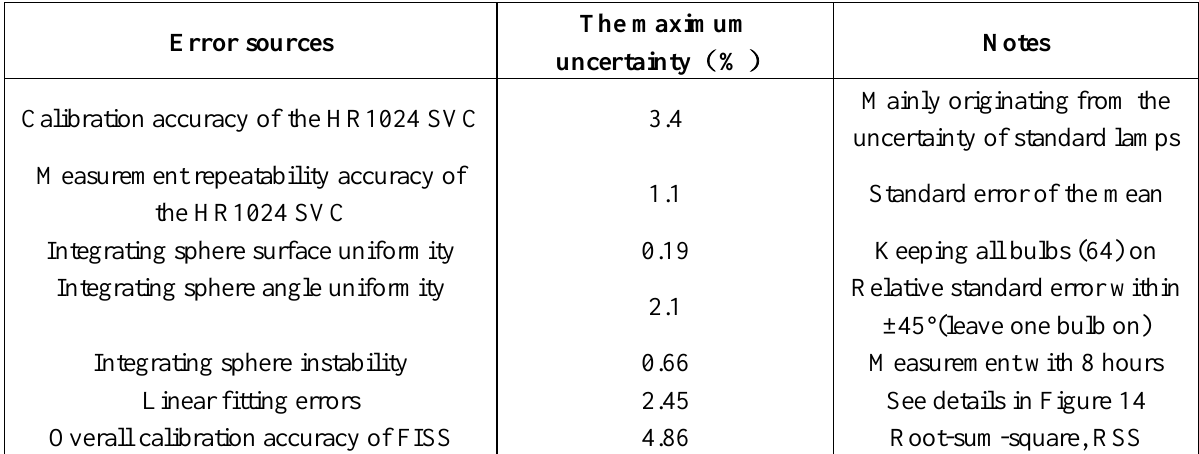
Table 4. FISS absolute radiometric